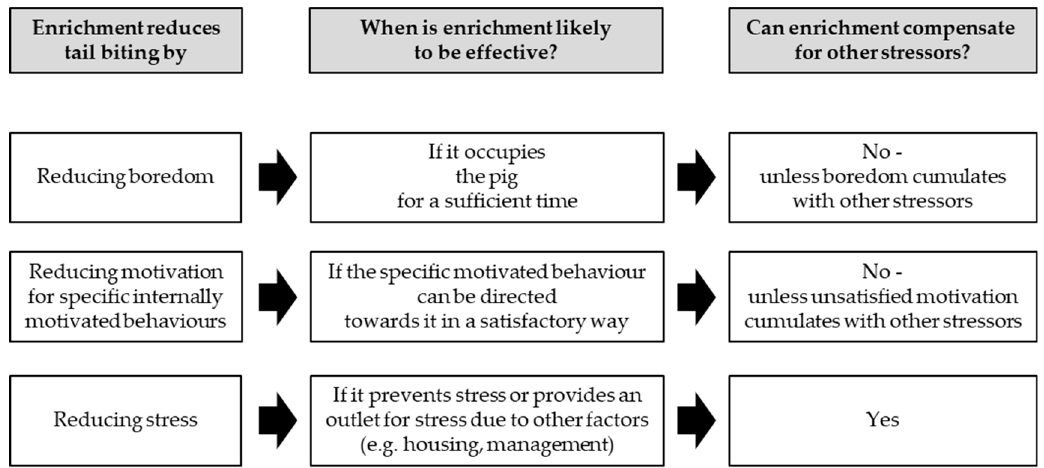
Figure 1. Potential mechanisms by which enrichment reduces tail biting and their consequences for the types of enrichment that are likely to be effective and interaction with other stressors. types of enrichment that are likely to be e ff ective and interaction with other